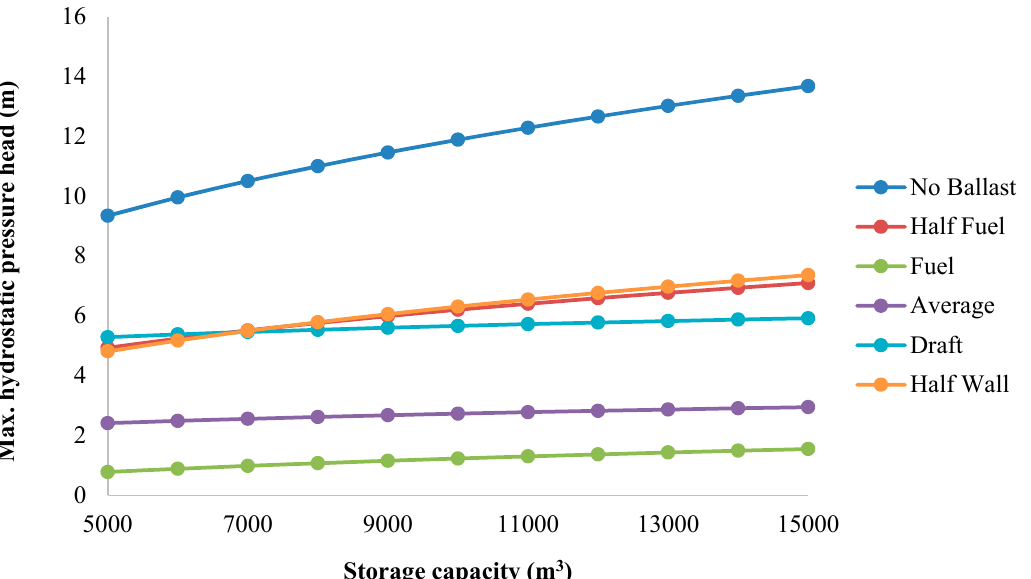
Figure 28. Maximum hydrostatic pressure head on outer tank wall.